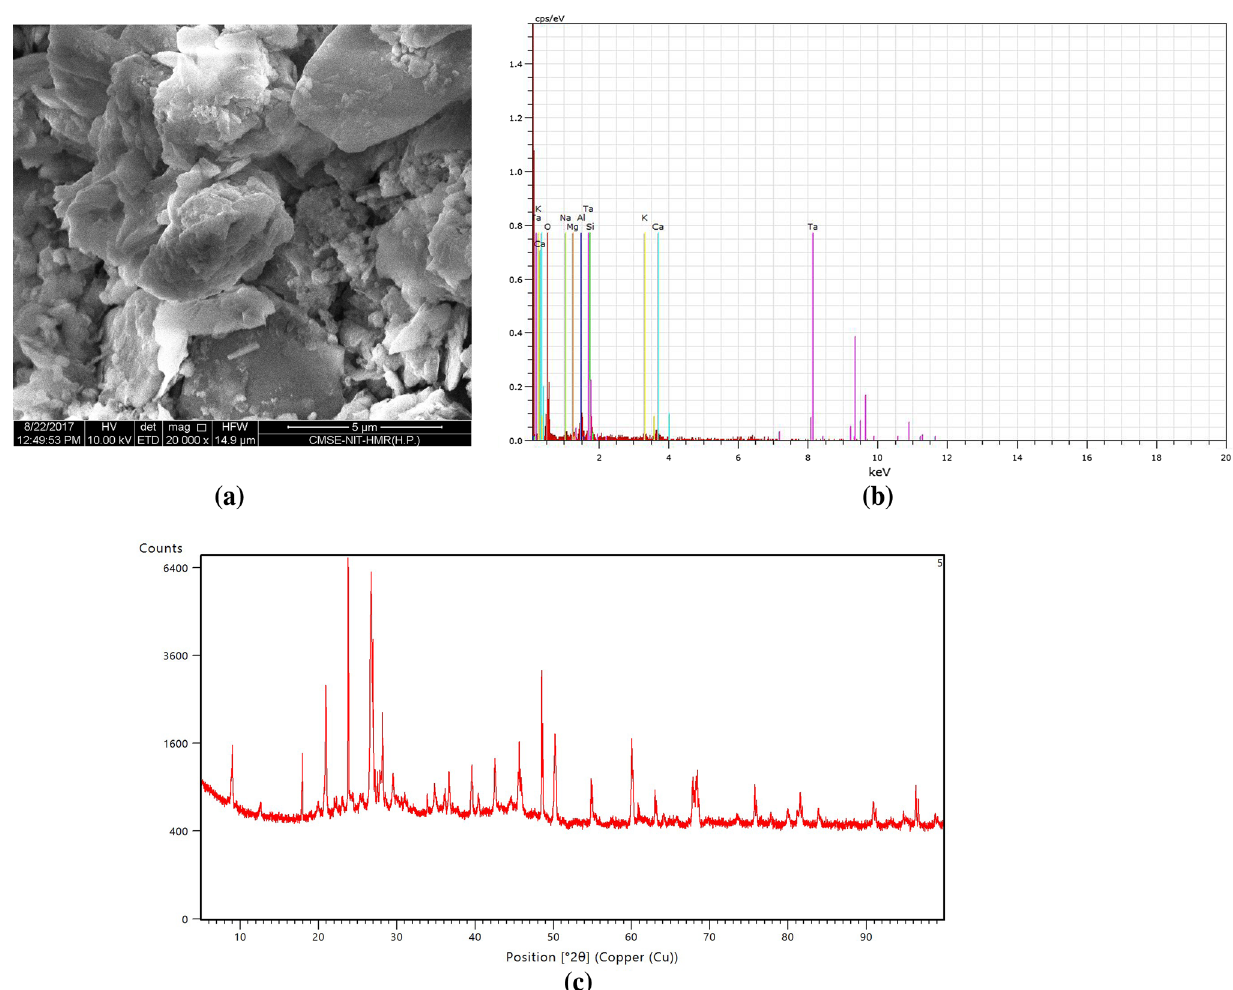
Fig. 2 SEM, EDS and XRD analyses of 20th day compost (Solan